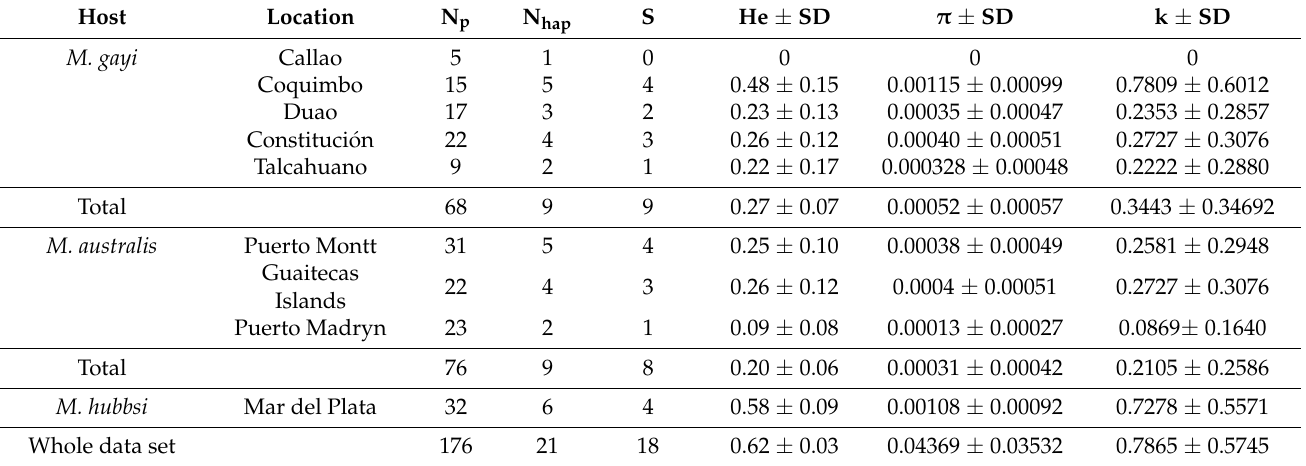
Table 2. Mitochondrial cox1 diversity for Aporocotyle by host and locality. N p = number of parasites analyzed; N hap = number of haplotypes; S = number of polymorphic sites; He = haplotype diversity; π = nucleotide diversity; k = mean number of pairwise differences. Standard deviations (SD) are also given.